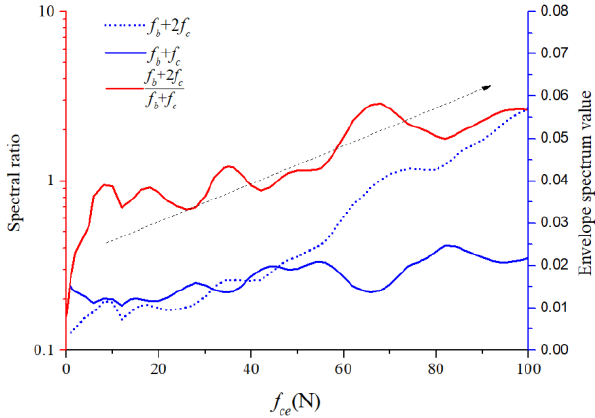
Figure 34. Modulation of upper sideband graph.